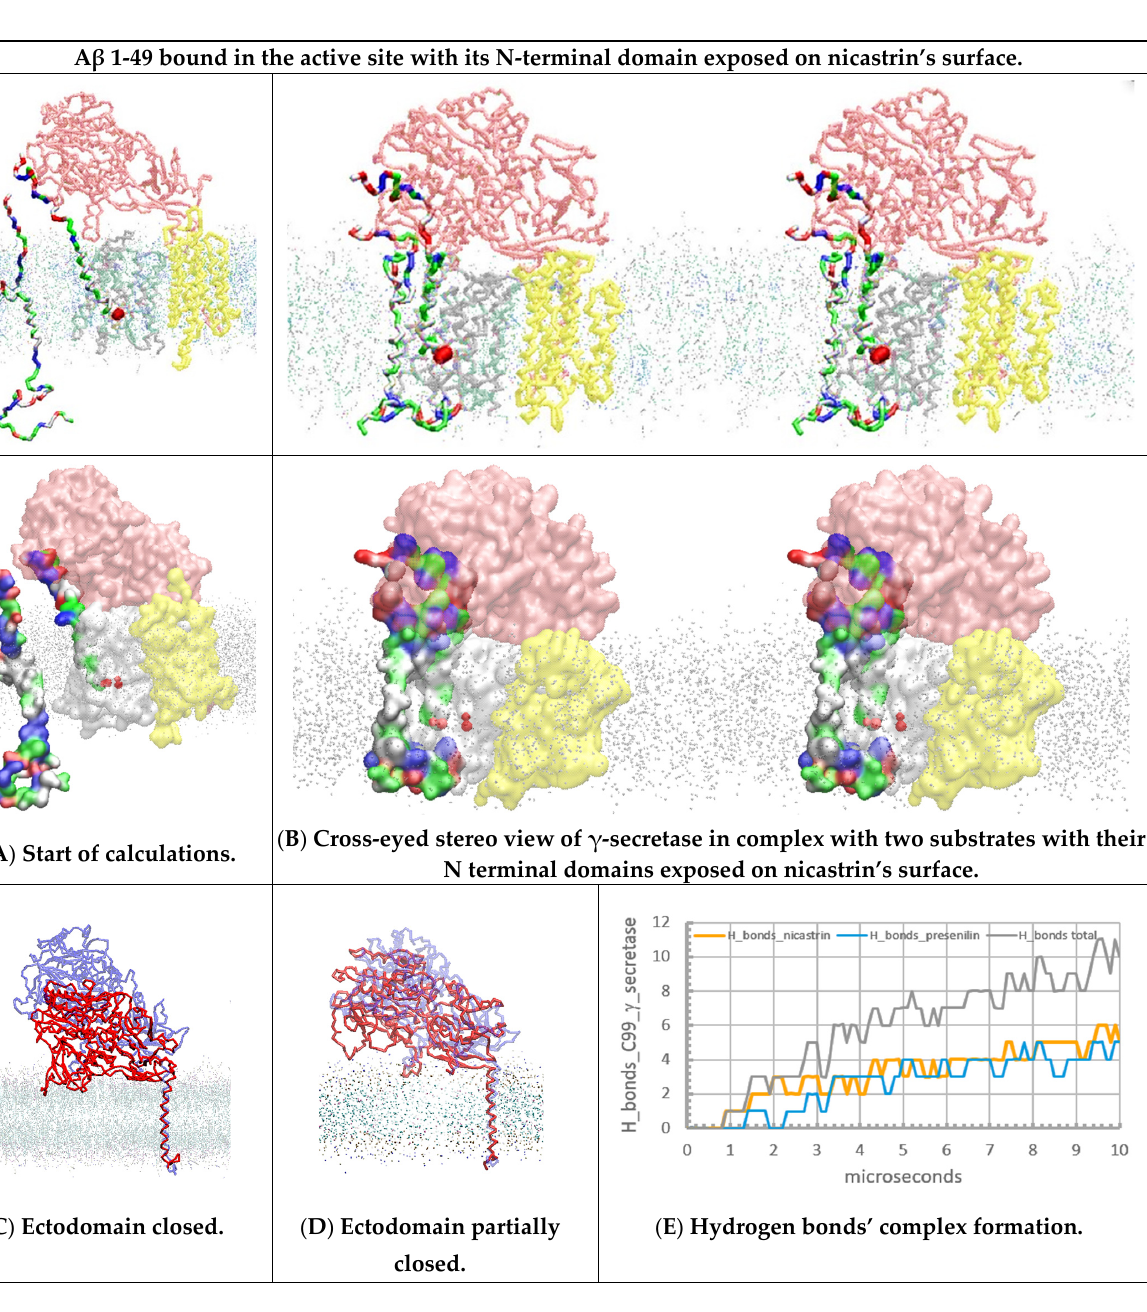
Figure 4. ( A–E ) Multiscale MD studies of the docking of the free C99- β CTF-APP substrate to γ -secretase: A β 1-49 substrate exposed on the external nicastrin surface. The γ -secretase complex (PDB:6IYC, [46] ) shows nicastrin (pink), presenilin 1 (white), and Aph1 and Pen2 (yellow) subunits. Red beads depict the active sites Asp 257 and Asp 385. The cholesterol–lipid bilayer is shown as dots (Materials and Methods). Surfaces of the free C99- β CTF-APP (PDB:2LP1 [33] ) and bound